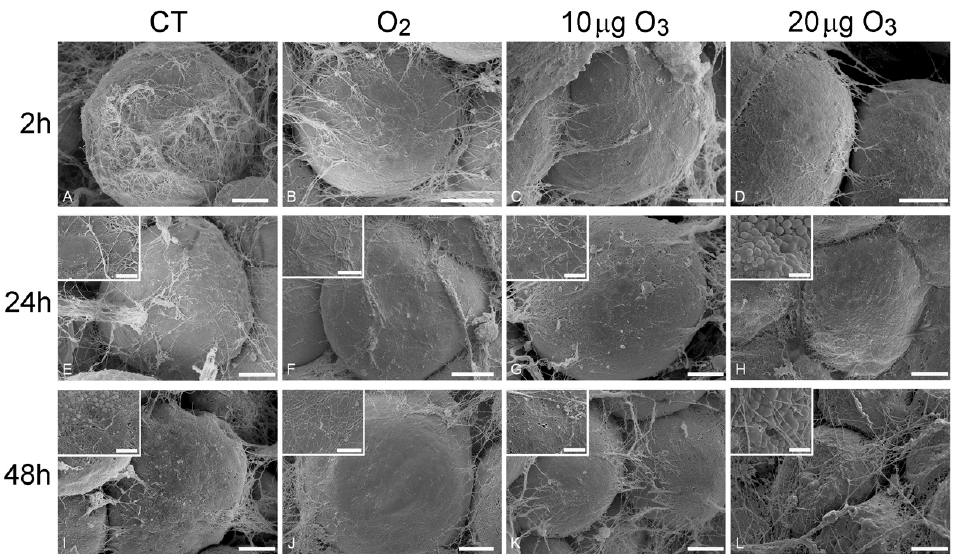
Figure 2. Scanning electron micrographs of adipocytes 2 h ( A – D ), 24 h ( E – H ) and 48 h ( I – L ) after gas treatment. At 2 h, the adipocytes were spherical with smooth surface and surrounded by an extracellular network of thin collagen fibres in control ( A ), O 2 - ( B ), 10 µ g O 3 - ( C ) and 20 µ g O 3 - ( D ) treated samples. At 24 h, control ( E ), O 2 - ( F ) and 10 µ g O 3 - ( G ) treated samples maintained a well-preserved morphology, while adipocytes exposed to 20 µ g O 3 ( H ) showed small lipid droplets budding from the surface. At 48 h, control adipocytes ( I ) showed clusters of lipid droplets budding from the surface; O 2 ( J ) and 10 µ g O 3 ( K )-treated samples showed well-preserved spherical adipocytes with smooth surface. 20 µ g O 3 -treated samples ( L ) showed slight depressions and many budding lipid droplets. CT, control. Bars, 10 µ m ( A – L ), 2 µ m